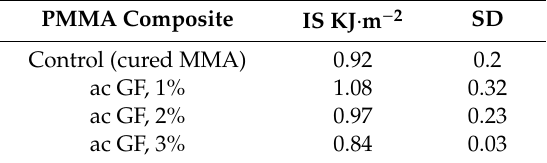
Figure 13. Effect of adding filler particles on impact strength of resins. Table 2. Effect of adding filler particles on impact strength of resins. Table 2. E ff ect of adding filler particles on impact strength of resins.